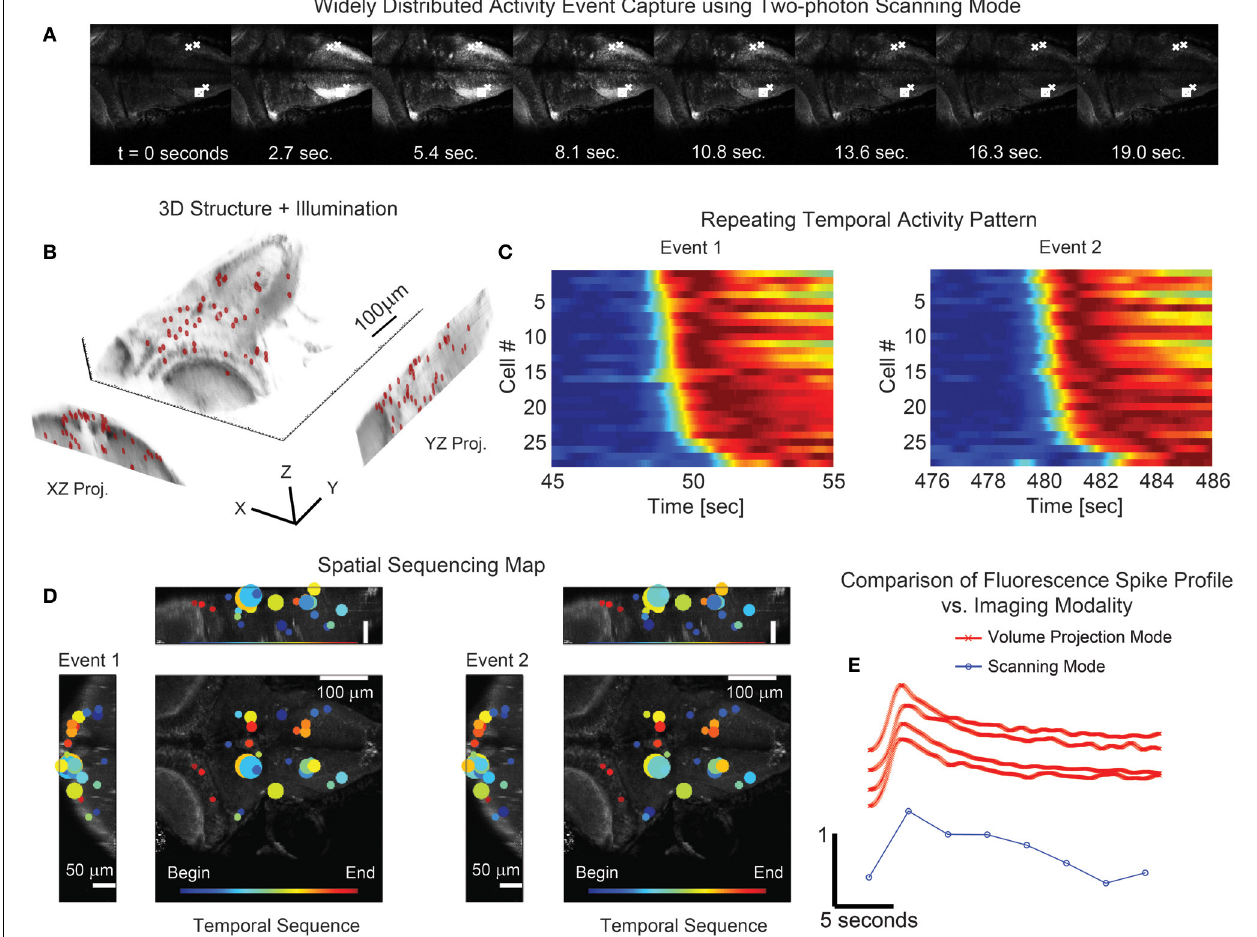
FIGURE 7 | Simultaneous 3D imaging of neuronal activity of zebrafish in vivo at 30 volume projections per second. (A) Conventional single plane two-photon raster-scan data acquisition reveals sequences of coordinated whole-brain activity. (B) 49 targets are distributed throughout an acquisition volume of 284 × 270 × 114 μ m to sample activity in 3D. (C) Multiple repetitions of these events occur and exhibit similar time-courses. (D) The associated spatial patterns of the events confirm that the activity has repetitive structure. The size of the